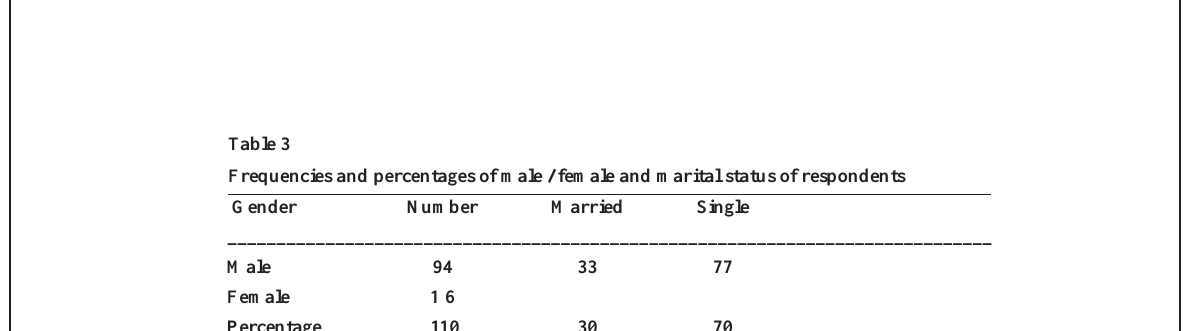
Table 4 represent the Pearson's co-efficient of correlation of the variables under study. Pearson Correlation was used in order to compare the means of Job Stress, Employee Performance, Job Satisfaction and Workload Pressure at a confidence interval of (P <0.01). The results explained a significant correlation among the four variables.